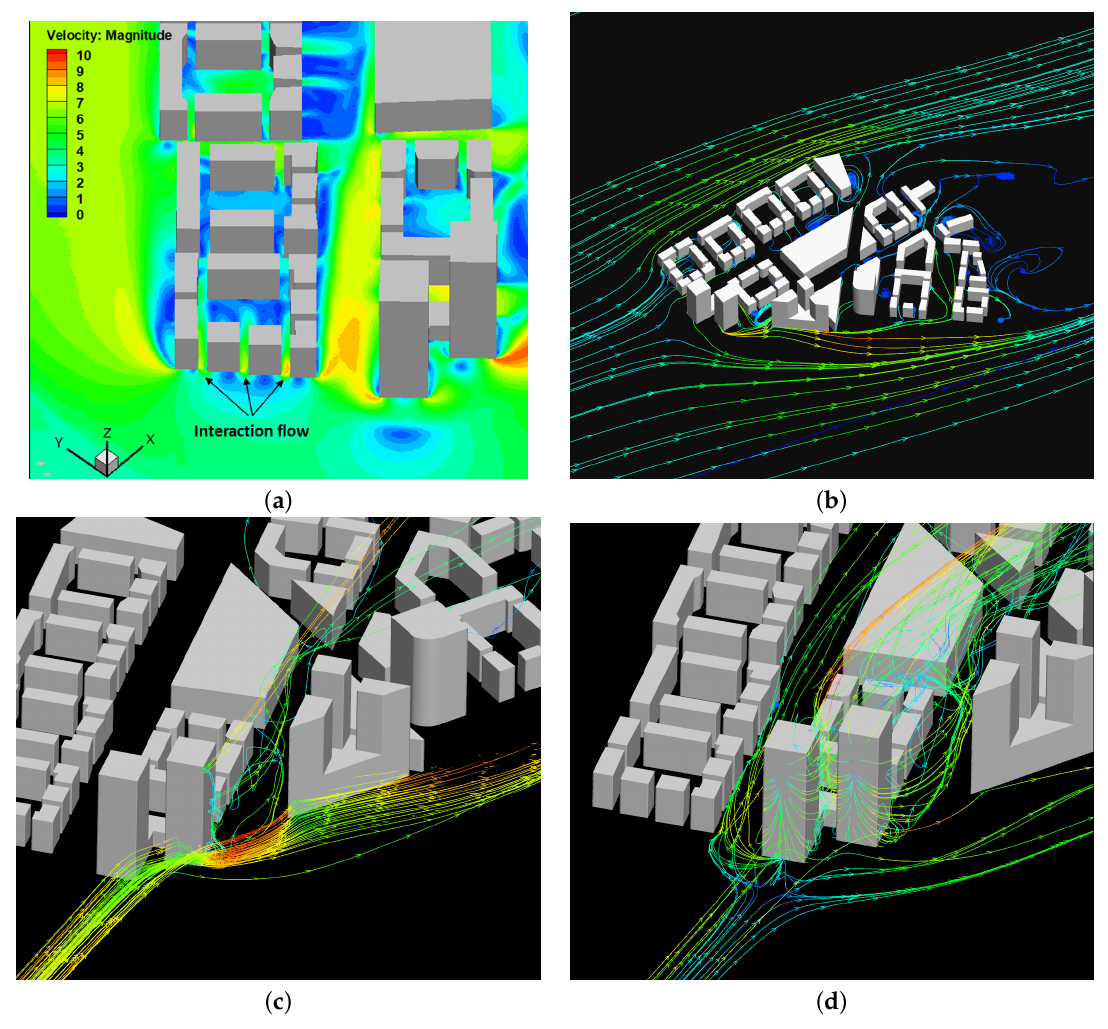
Figure 8. Velocity streamlines: ( a ) interaction flow, ( b ) flow separation, ( c ) corner effect, ( d ) downwash